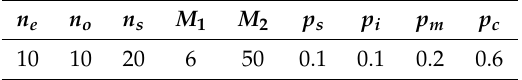
Table 5. Parameters of